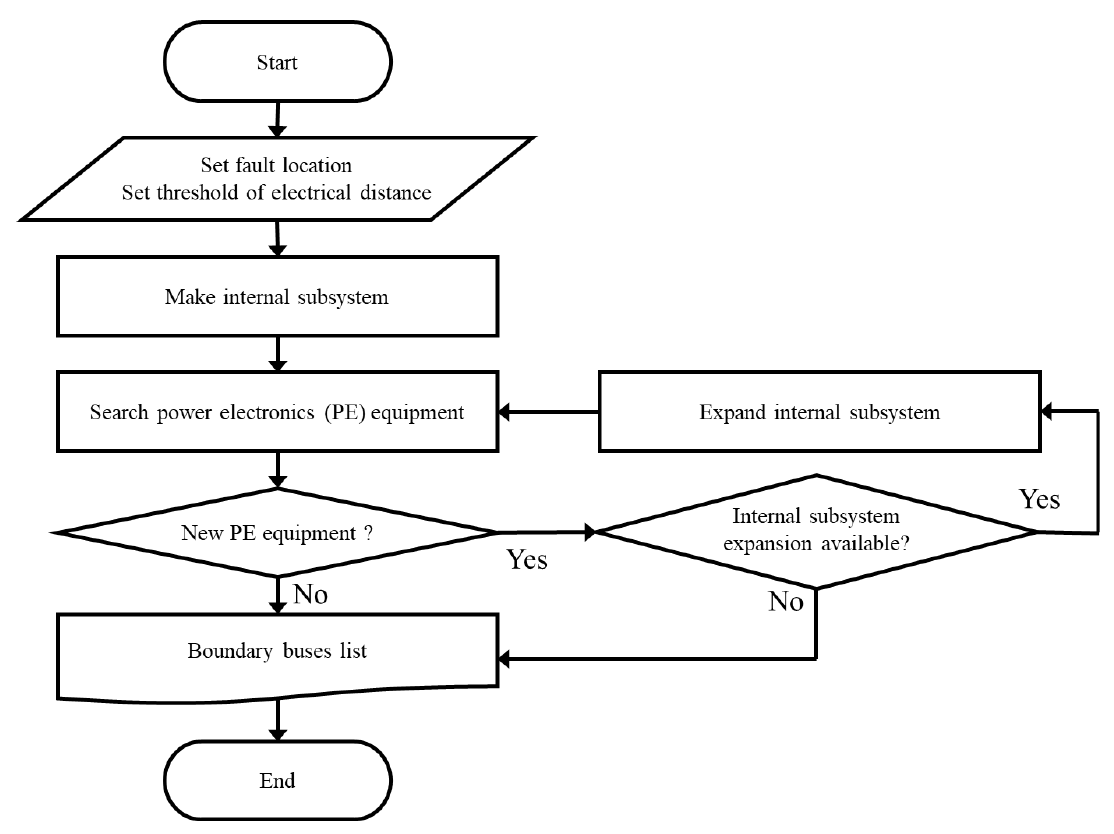
Figure 6. The procedure of determination of boundary buses.